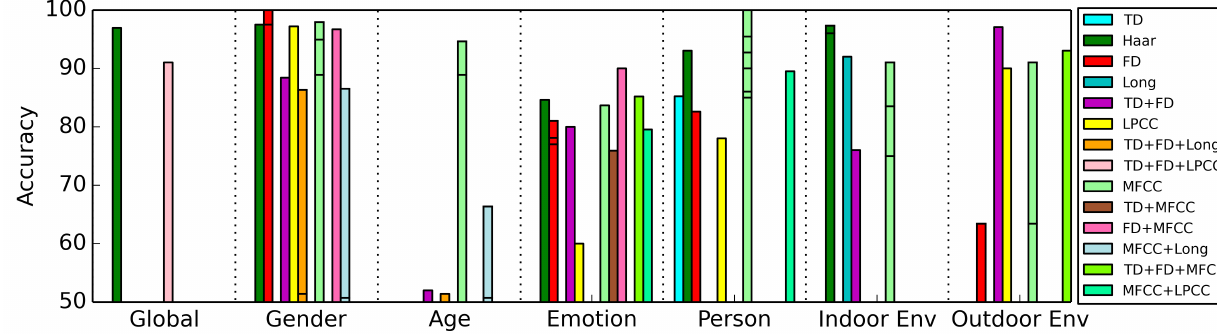
Figure 13. Overview of feature comparisons, grouped by